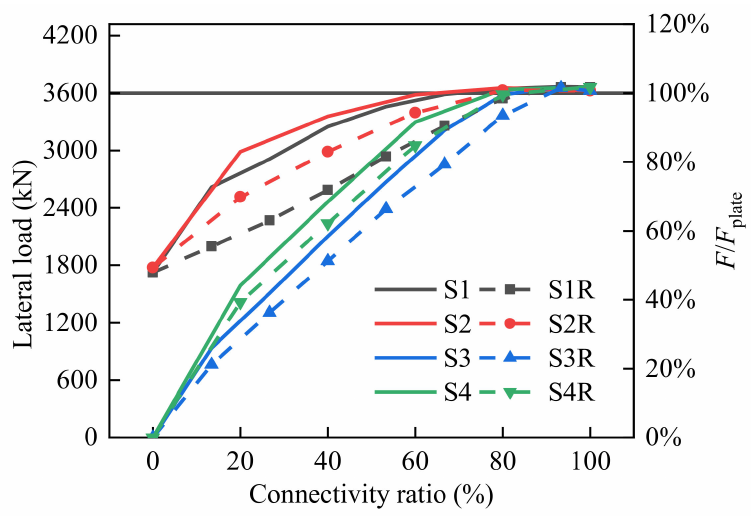
Figure 12. Relationship between shear strength and connectivity